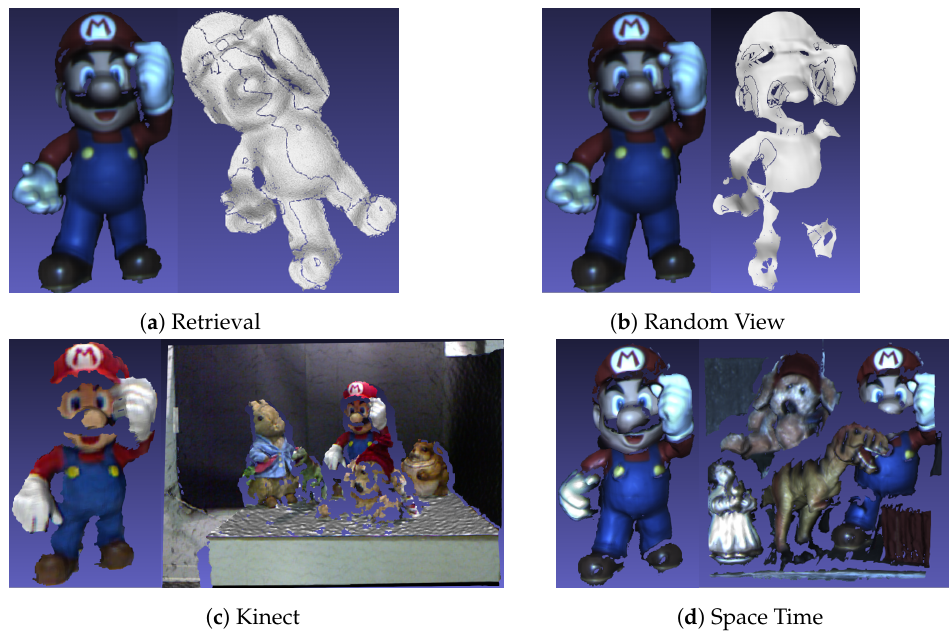
Figure 6. Mario Model in the